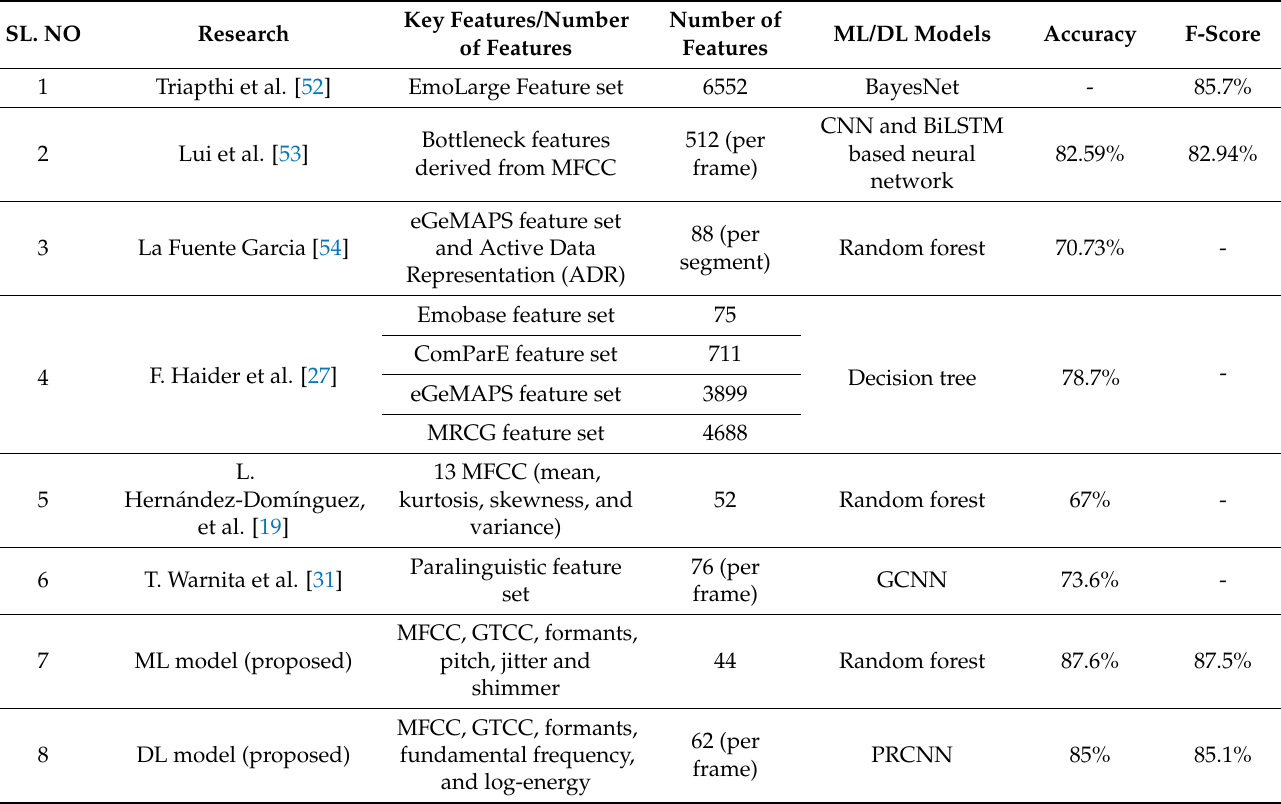
Table 4. Comparisons of research on Dementia Bank (Cookie theft description task) using only speech